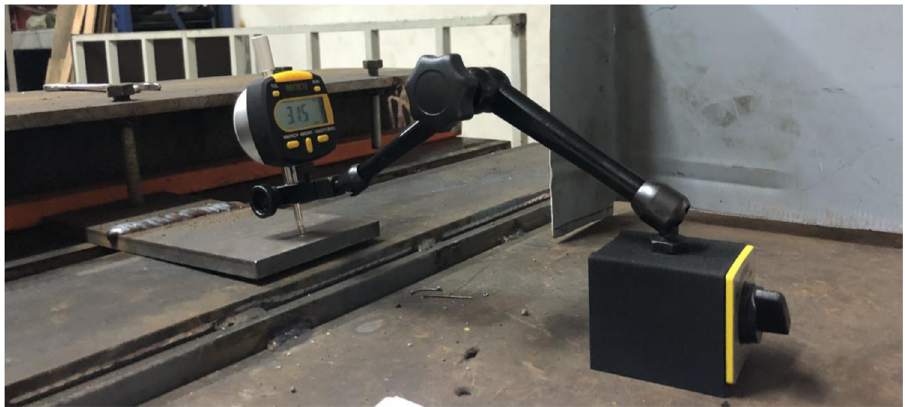
Figure 1: The welded workpiece and the dial indicator.